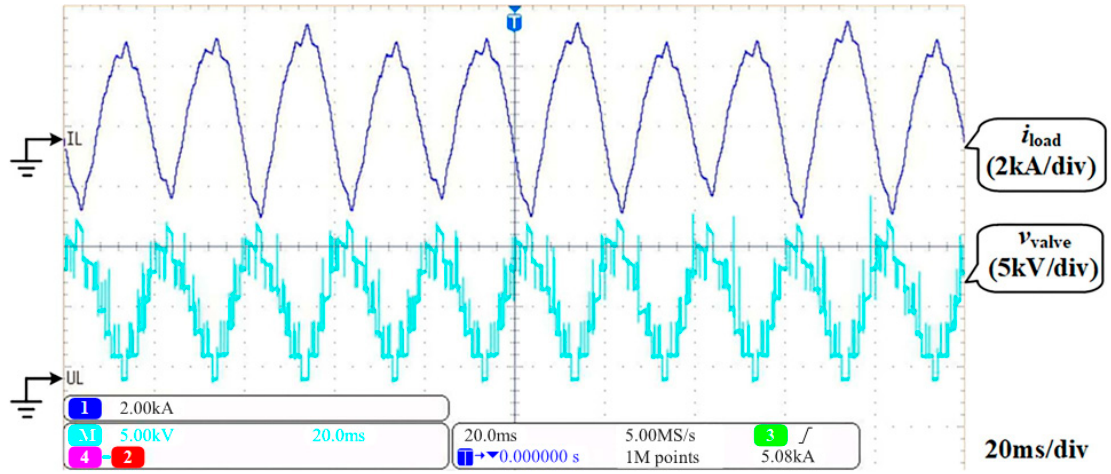
Figure 14. Waveforms of MMC valve.